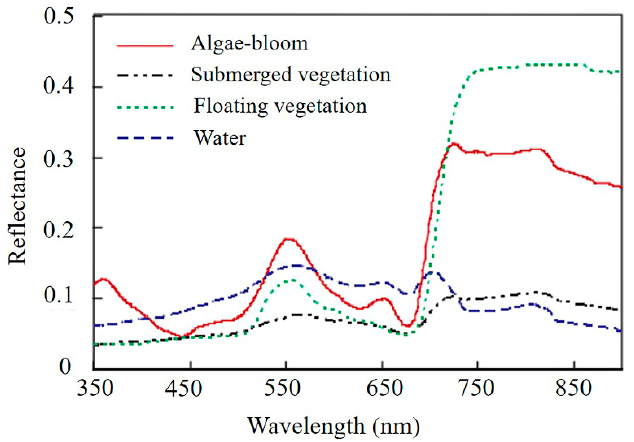
Figure 5. Representative reflectance spectra of the algae-bloom, water, submerged vegetation, and floating vegetation at Taihu Lake (from Li et al. [23]).